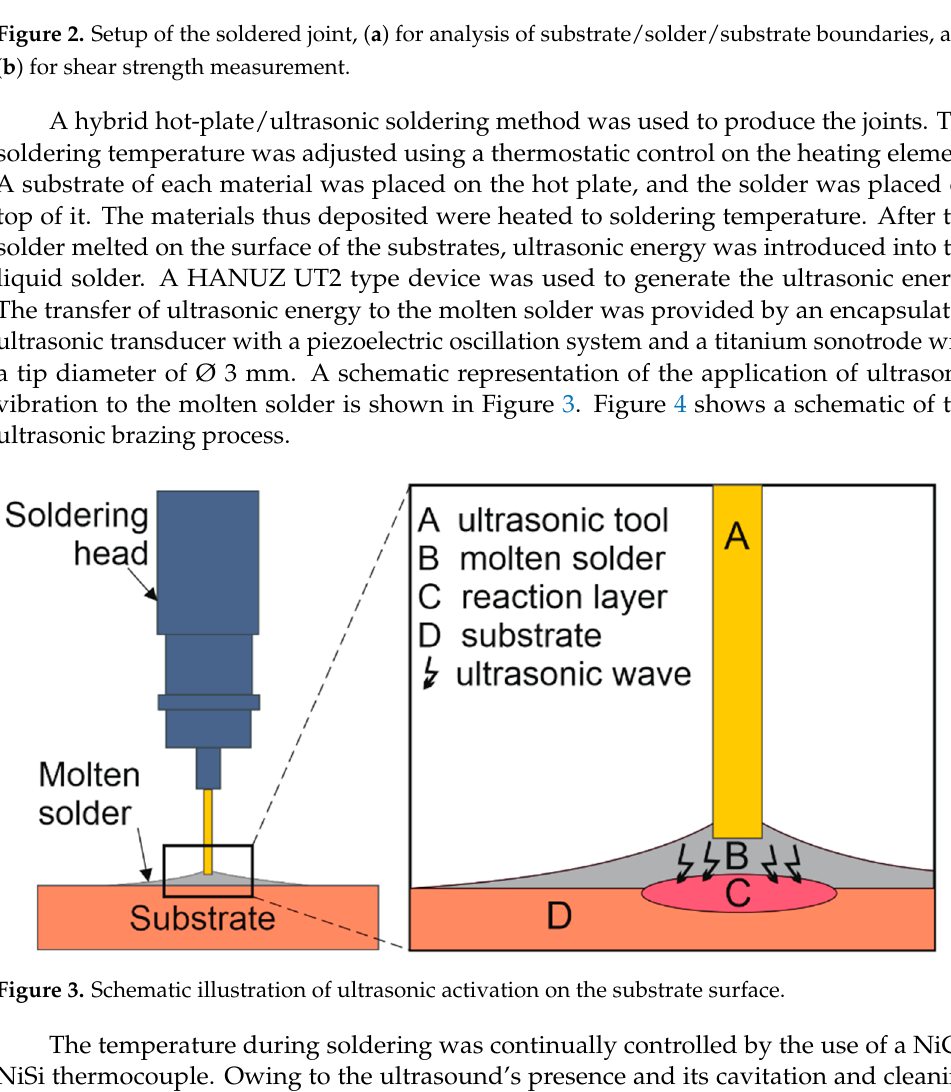
Figure 2. Setup of the soldered joint, ( a ) for analysis of substrate/solder/substrate boundaries, and ( b ) for shear strength measurement.